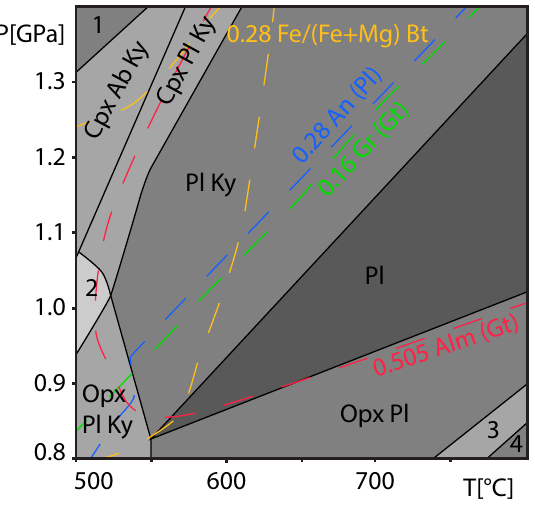
Figure 7. Pseudosection calculated for F68. Additional phases in all fields: Kfs + Grt + Bt + Qz + Rt. With isopleths for Fe/(Fe + Mg) in biotite, the anorthite component of plagioclase (An (Pl)), and the grossular and almandine component of garnet (Gr, Alm